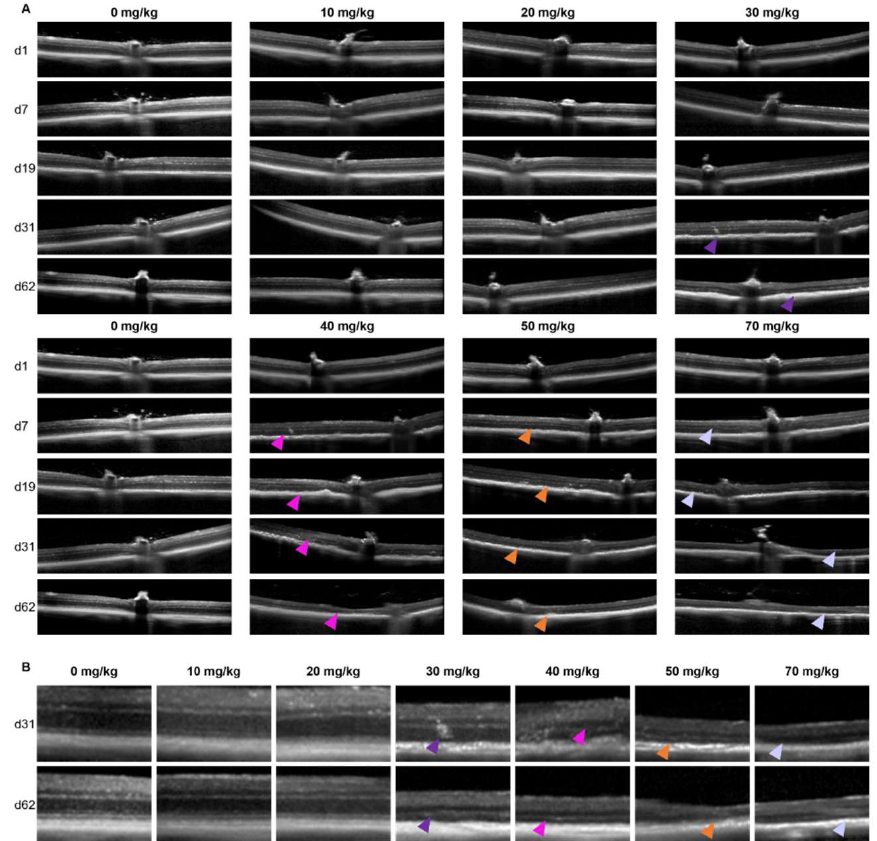
Figure 1. Representative serial OCT images of C57BL/6J mice of the central retina ( A ) and a magnification at the later timepoints ( B ) are shown. Serial scans are shown from single animals within the treatment group. In panel ( A ) the doses are horizontally shown in increasing concentration. The day of follow-up is shown vertically. No clear effects were observed for the 10 and 20 mg/kg groups compared to the control. Retinal degenerations was observed in all other groups. This is also better visible in panel ( B ), where the zoomed-in scans are shown per concentration SI (horizontally) and the later follow-up times (vertically). In the 30 mg/kg treatment group, retinal thinning started to show roughly 1 month post-injection (purple arrows). More drastic effects at the end of the experiments were observed for the 40 (pink arrows), 50 (orange arrows) and 70 mg/kg (lilac arrows) treatment groups. Quantification of the overall retinal thickness is shown in Figure 3.